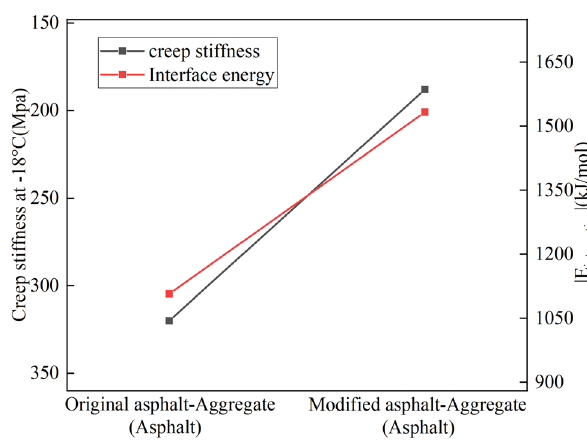
Figure 23: Validation of BBR test results and simulation